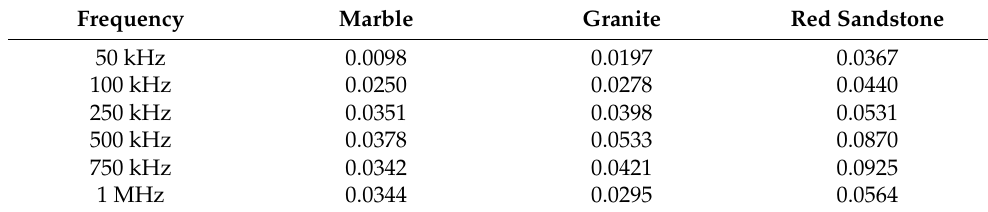
Figure 5. Attenuation of amplitudes in ( a ) marble, ( b ) granite, and ( c ) red sandstone at different frequencies. Table 3. Attenuation coefficients of the samples (Np · cm − 1 ). Frequency Marble Granite Red